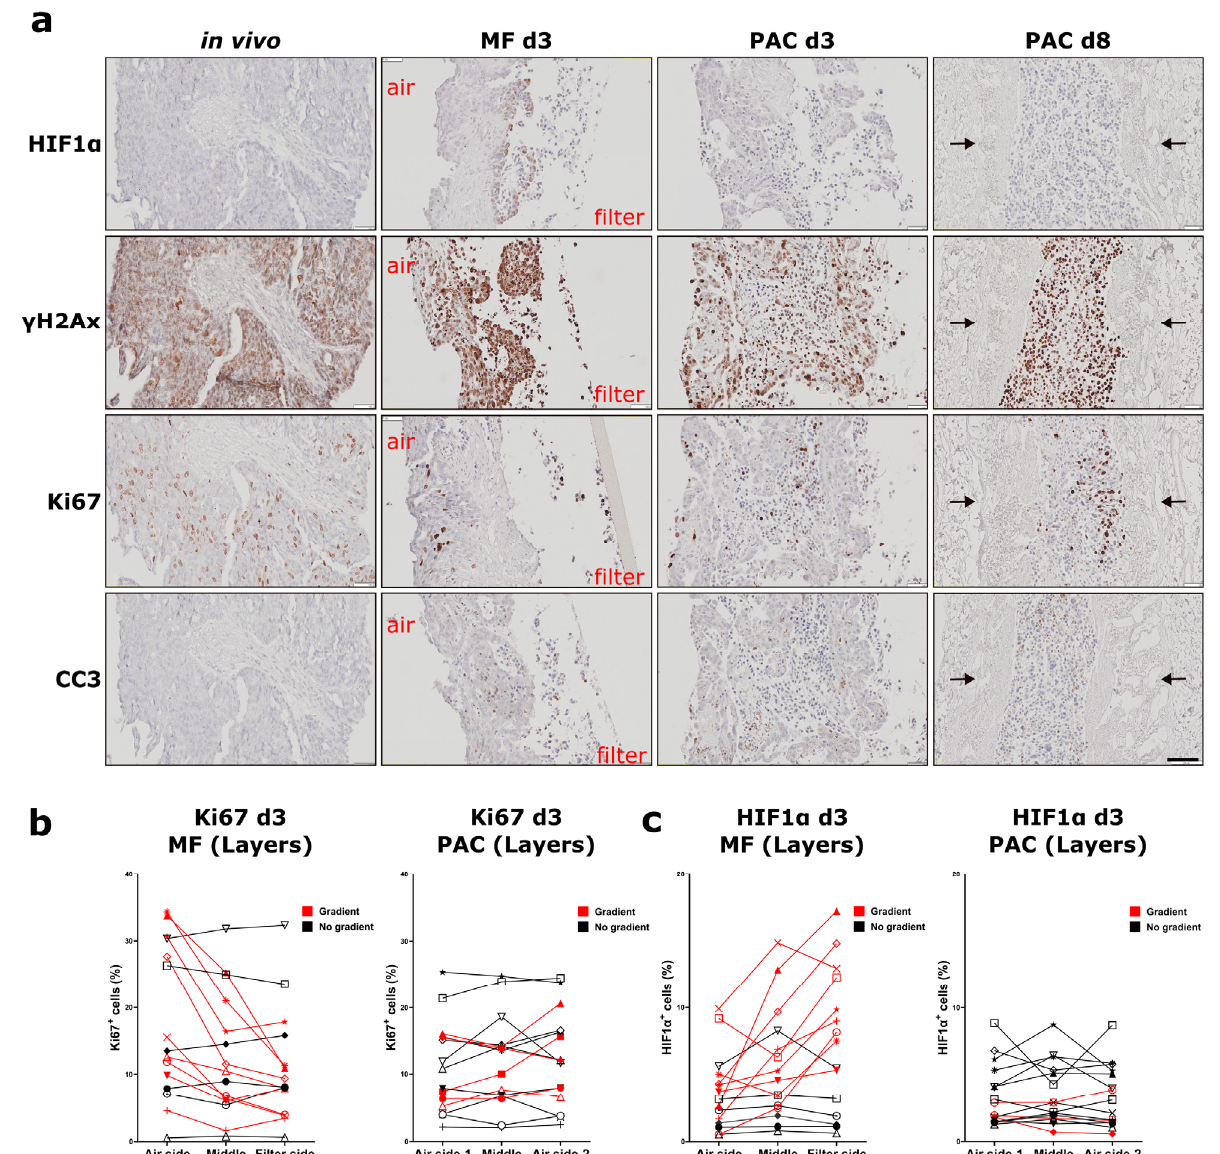
Figure 5. Expression of hypoxia-inducible factor 1 α (HIF1 α ), phospho-histone H2A.X ( γ H2AX), Ki67, and cleaved-caspase 3 (CC3) of primary human ovarian tumor slices in the Millipore filter (MF) culture system (3 days) and perfusion air culture (PAC) system (3 days and 8 days). ( a ) Immunohistochemical (IHC) staining of biomarkers in primary human ovarian tumor slices after 3 days cultivation